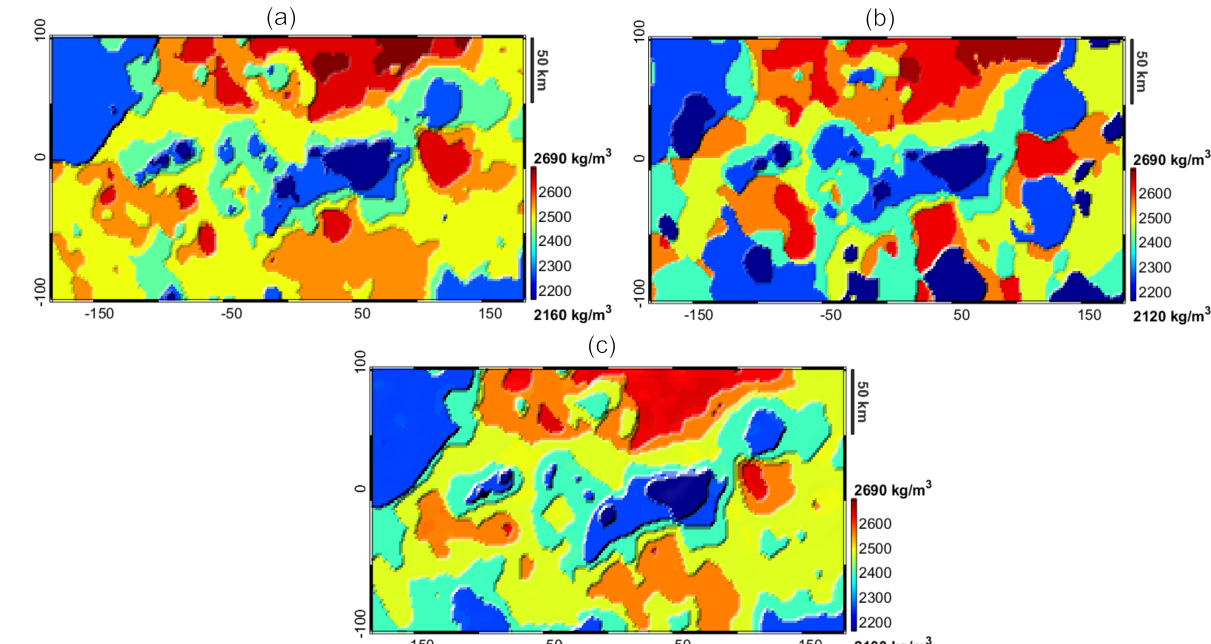
Figure 14. Density distribution at a depth of 5000 m from the true ( a ), a priori ( b ) and a posteriori models ( c